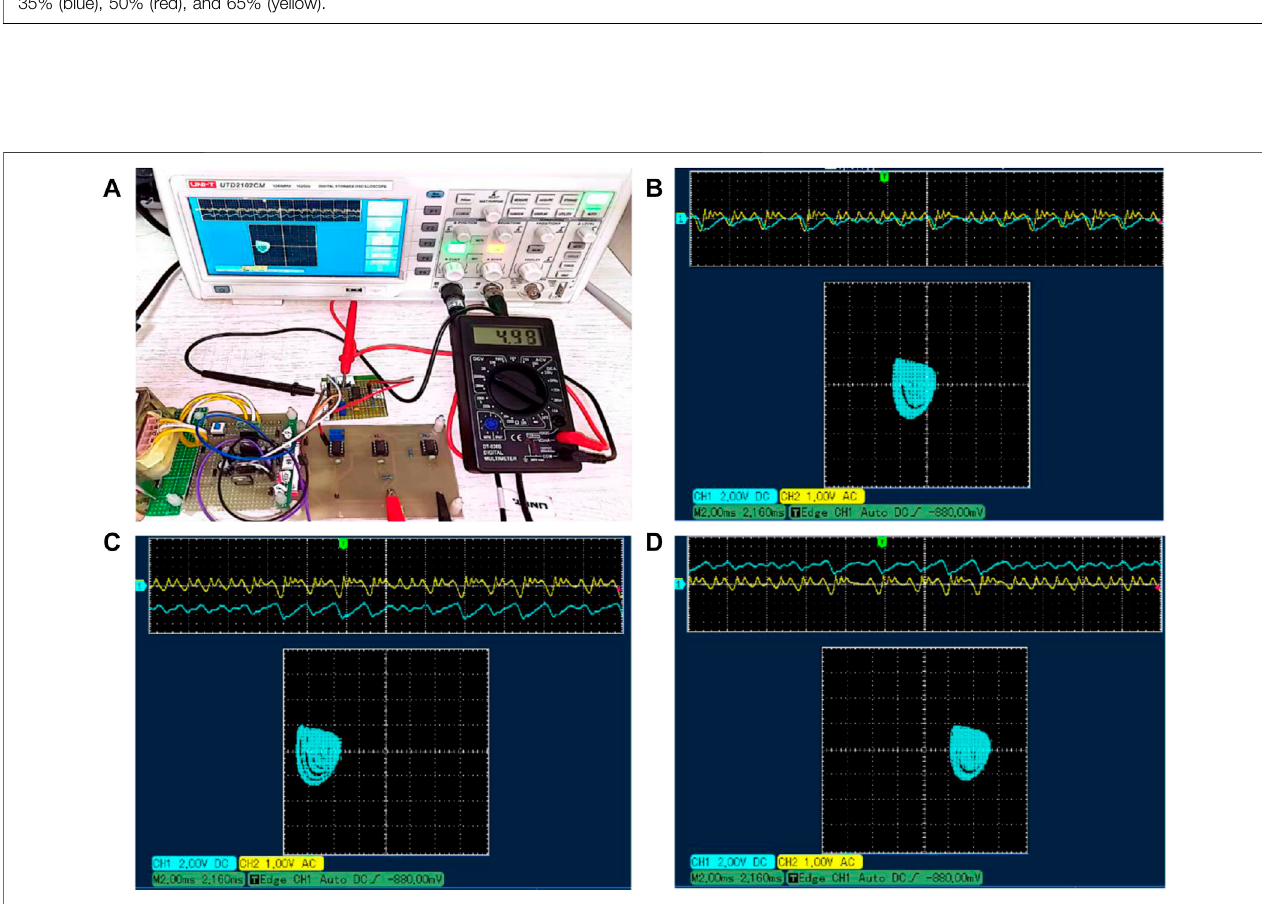
FIGURE9| Offsetboostingwithactualcircuitimplementationandits x-y planephasediagramsinoscilloscope. (A) Actualexperimental test. (B) V k = − 4.5V. (C) V k = 0 V. (D) V k = 4.5 V.